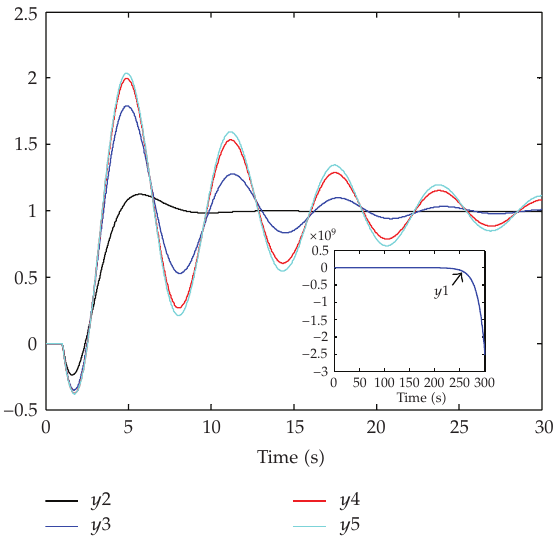
Figure 5: The influence of the upper bound γ of (cid:3) S (cid:3) ∞ .